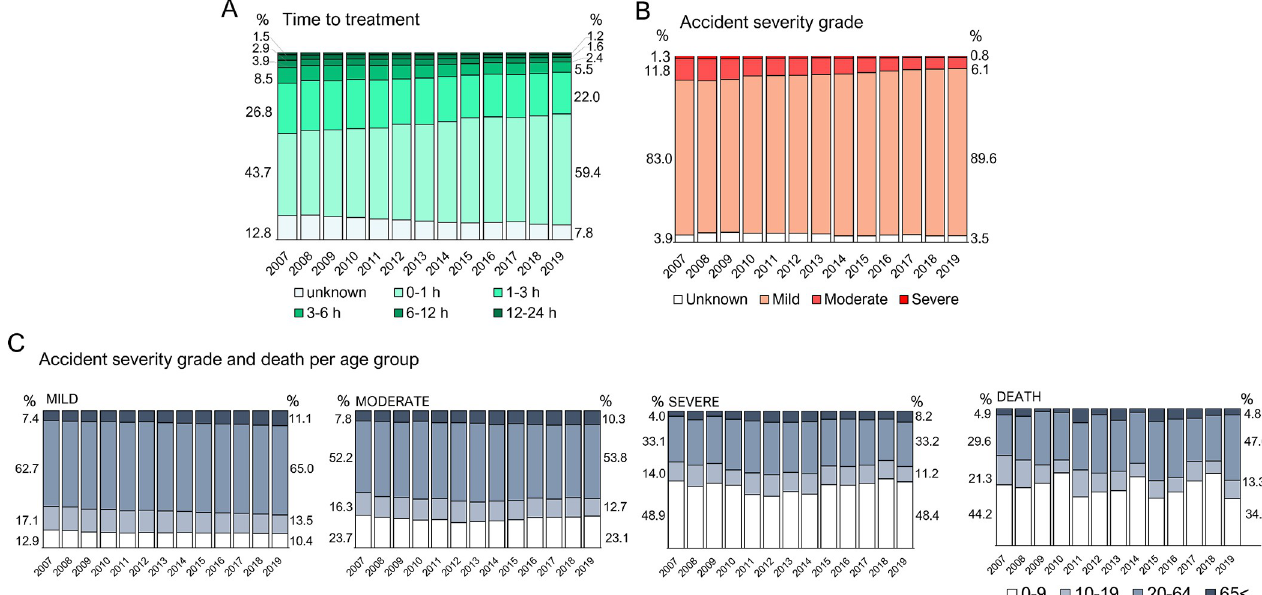
Fig 3. Medical aspects of scorpion accidents from 2007 to 2019. Bar AU : Pleasecheckandconfirmthattheeditstothesentence } Bargraphsshowtheproportionofscorpionismvictimsalongthe ::: } didnotaltertheintendedthoughtofthesentence : graphs show the proportion of scorpionism victims along the years according to ( A ) the time elapsed from the accident until they searched for treatment, ( B ) the severity grade of envenoming, and ( C ) the age distribution of scorpionism victims according to accident severity grade and death. Numbers next to the first and the last bars represent the percentage of each analyzed group in the year of 2007 (left) and 2019 (right). Graphs were produced using Microsoft365 Excel software. Scorpion accidents’ information were recovered from the SINAN Database.